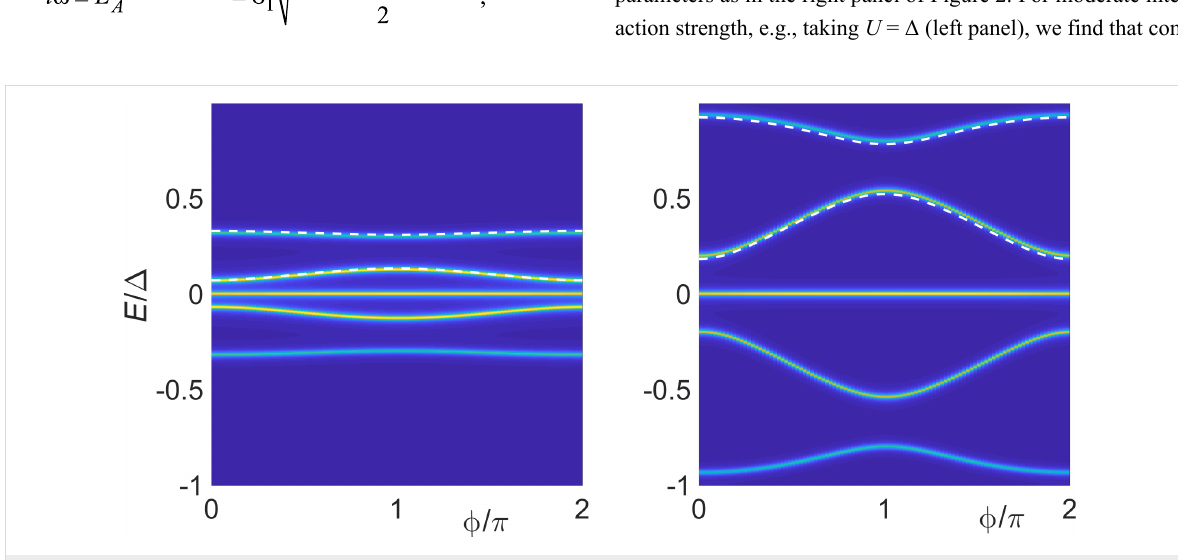
Figure 2: Phase dependence of the subgap spectrum of an S–QD–TS junction in the noninteracting case, U = 0. The TS wire is modeled from the low-energy limit of a Kitaev chain, and we use the parameters B y = 0, B x = B z = B / , ε 0 = 0, Δ p = Δ , and Γ S = Γ TS = Γ . From blue to yellow, the color code indicates increasing values of the spectral density. The left (right) panel is for Γ = 0.045 Δ and B = 0.1 Δ ( Γ = B = 0.5 Δ ). Solid curves were ob- tained by numerical evaluation of Equation 30. Dashed curves give the analytical prediction (Equation 32). In the right panel, the energies resulting from Equation 32 have been rescaled by the factor 1 + Γ / Δ